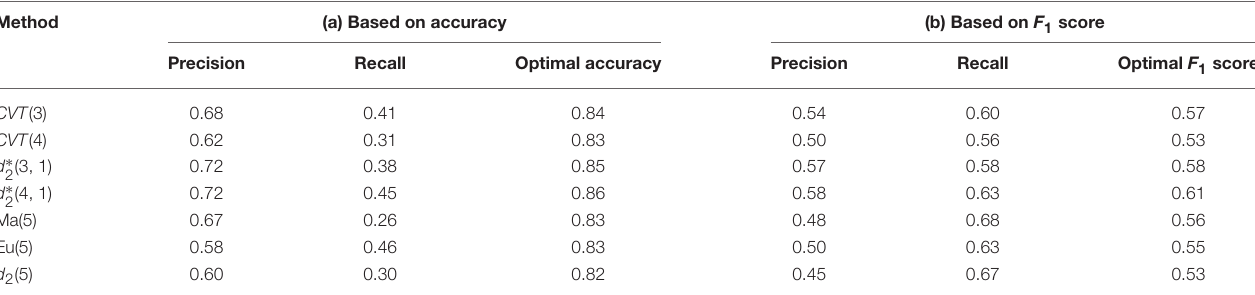
TABLE 4 | Performance of different methods over 118 genomes with known HGT genomic islands in Langille et al. (2008) based on (a) optimal accuracy and (b) optimal F 1